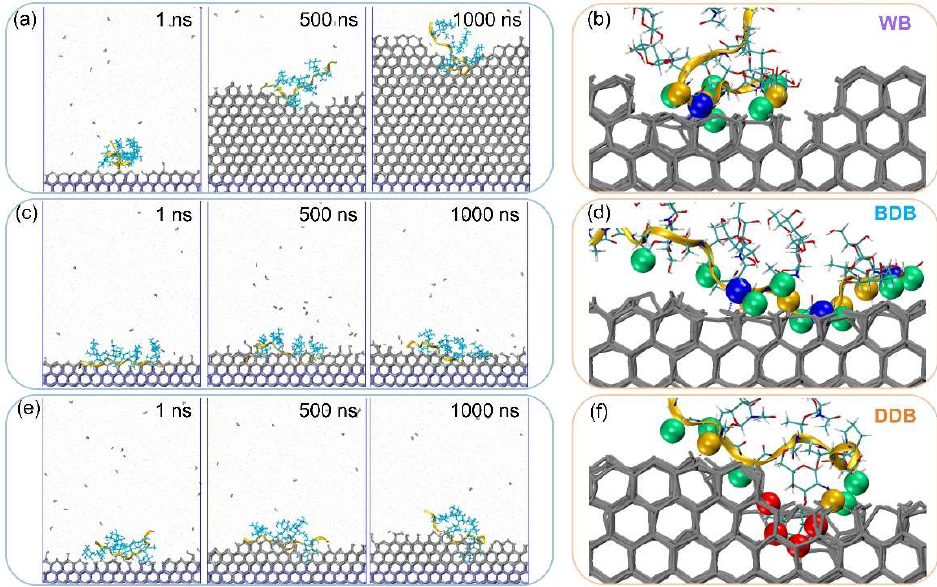
Figure 3. Hydrogen-bonding and hydrophobic groups contribute to the binding of AFGP8 to ice. Different representative snapshots (1 ns, 500 ns, 1000 ns, respectively) of three binding cases: weak binding ( a ), backbone dominant binding ( c ) and disaccharide dominant binding ( e ). The detailed binding cases are enlarged in panel ( b , d , f ), respectively. The bottom two layers of ice, colored in ice blue, are restrained by a harmonic potential. The free ice and liquid water molecules are shown by gray lines and gray dots, respectively. The color coding: methyl groups (green balls), O (orange balls) and N (bule balls) of amide groups and hydroxyl groups (red balls); the backbone of AFGP8 (orange ribbon), Thr residues (cyan or colorful licorice).